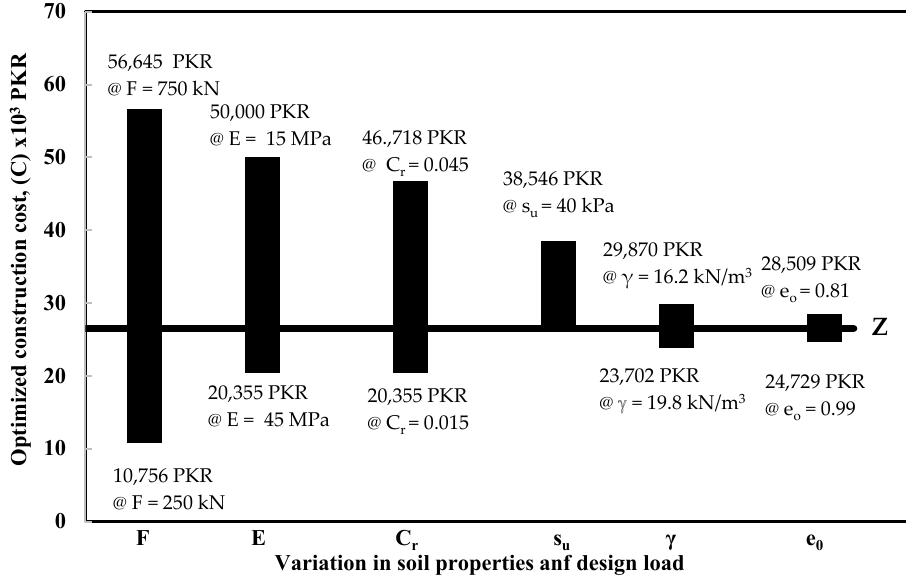
Figure 4. Sensitivity analysis with ±50% and ±10% variations.